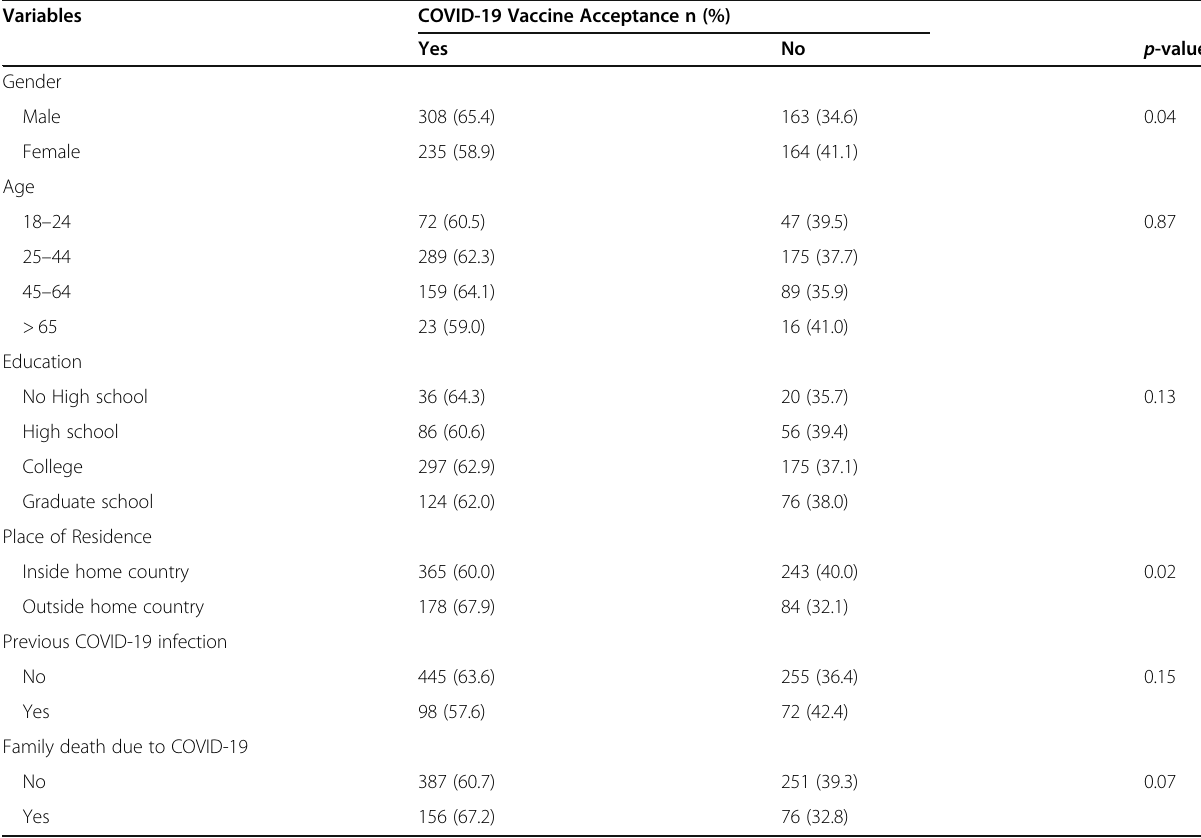
Table 2 Bivariate Associations Between Respondents Characteristics and COVID-19 Vaccine Acceptance ( N = 870) Variables